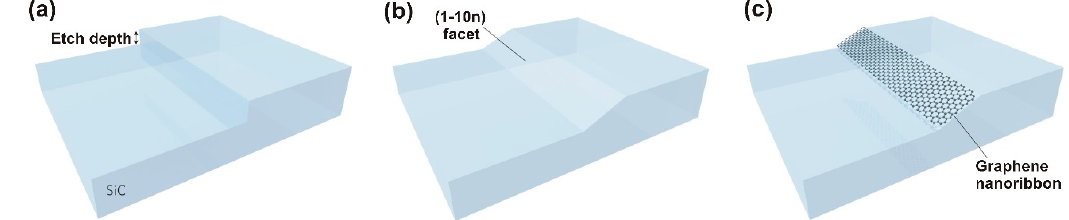
Figure 47. Process steps modifying the SiC substrate surface for graphene nanoribbon growth. ( a ) A nanometer-scale step is etched into SiC crystal by fluorine-based RIE. ( b ) The crystal is heated to 1200–1300 °C (at low vacuum), inducing step flow and relaxation to the (1–10n) facet. ( c ) Upon further heating to ~1450 °C, self-organized graphene nanoribbon forms on the facet [168].